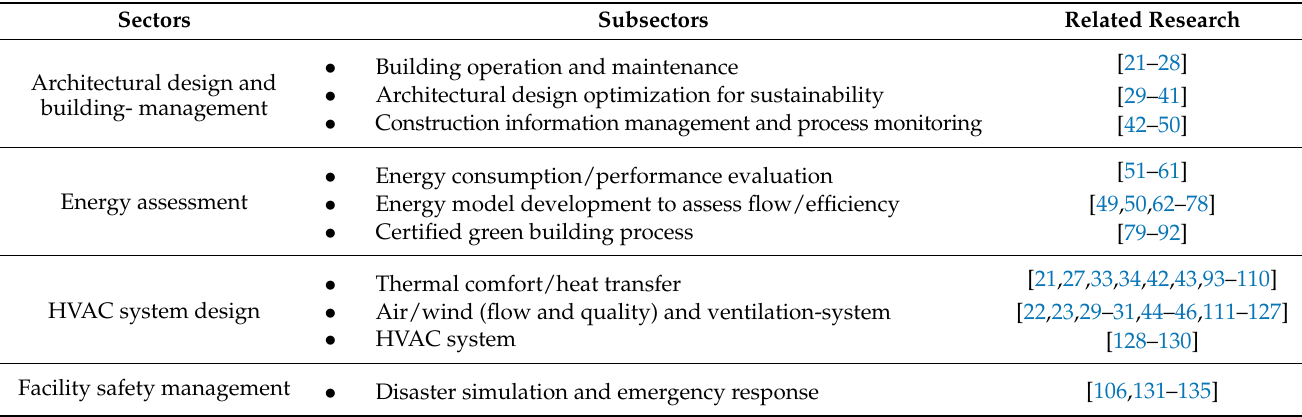
Figure 3. Categorized keywords associated with BIM and CFD integration. Table 3. Categorization of selected articles by topics.